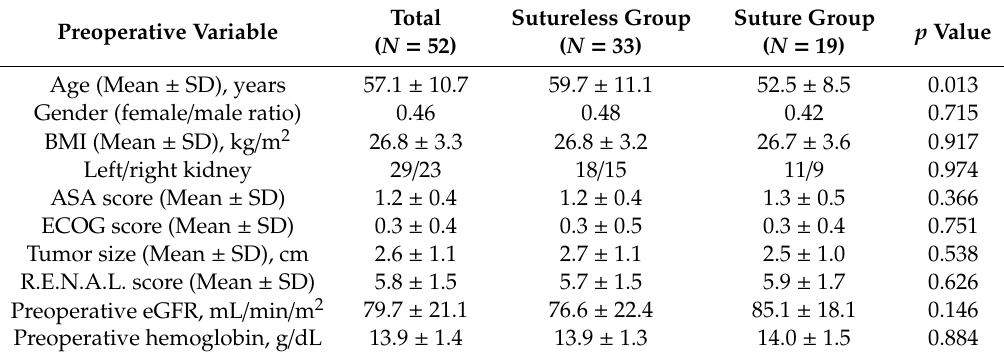
Table 1. Preoperative data on patients who underwent